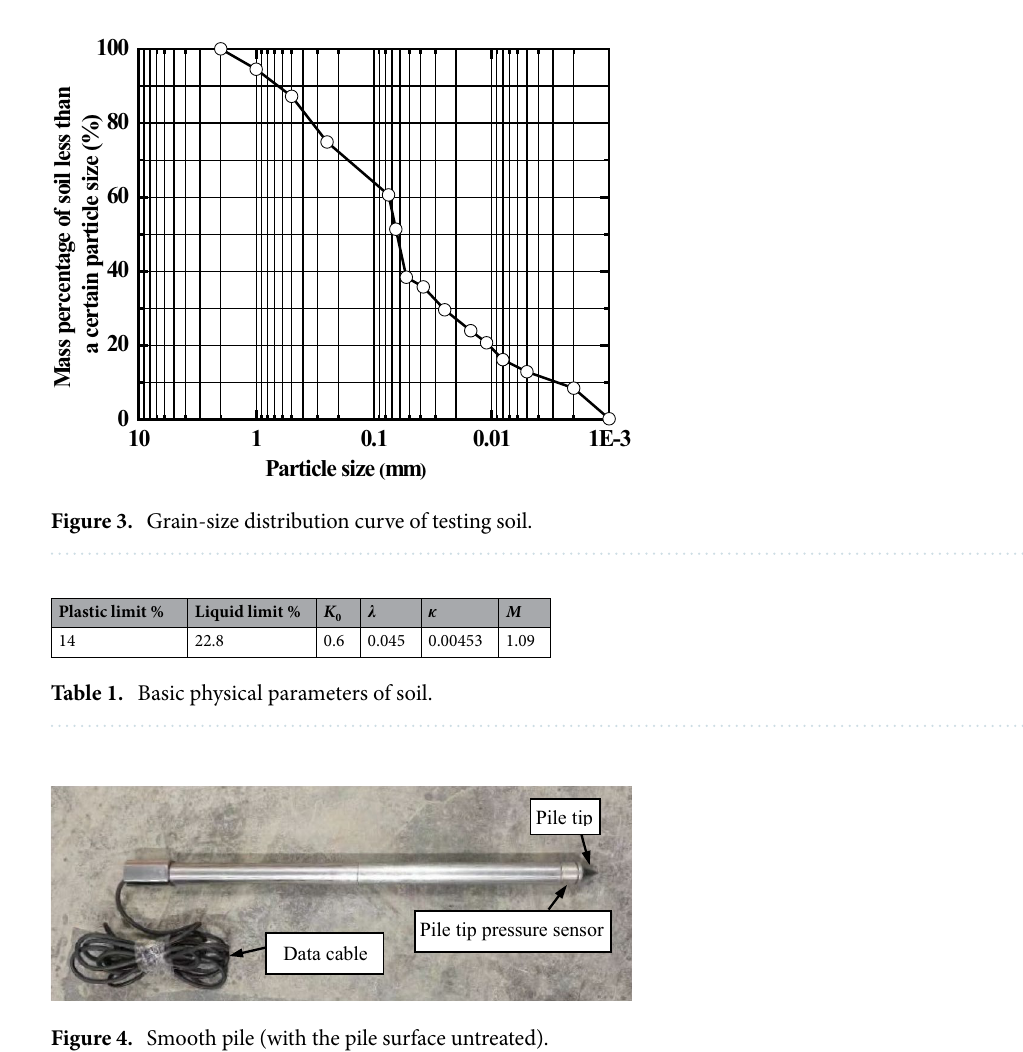
Figure 4. Smooth pile (with the pile surface untreated).